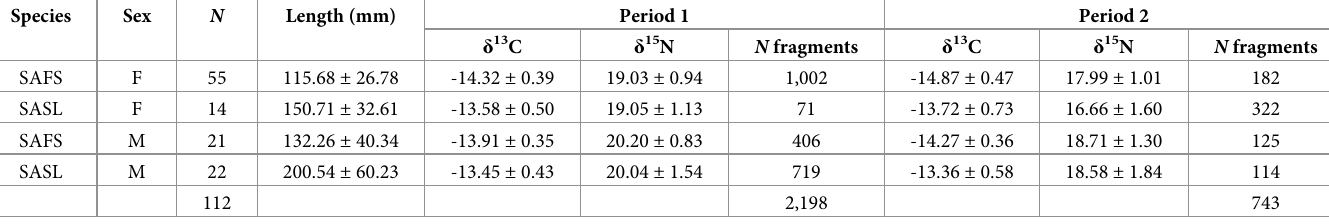
Isotopic niche size, overlap and community metrics according to period Standard ellipse areas (SEAc) increased in male groups of both species between Period 1 and Period 2 (11.03% in SAFS M and 16.27% in SASL M). In females, SEAc remained stable in Table 1. Isotopic signatures of Peruvian otariid whiskers according to periods investigated in present study. Species Sex N Length (mm) Period 1 Period 2 SAFS F 55 115.68 ± 26.78 SASL SAFS M 21 SASL M 22 200.54 ± 60.23 112 2,198 743 Number of whiskers ( N ), mean length (mm) by species and sex. Mean ± SD of the stable isotope values ( δ 13 C and δ 15 N) during two periods according to sea level. N fragments: Sample size for species and